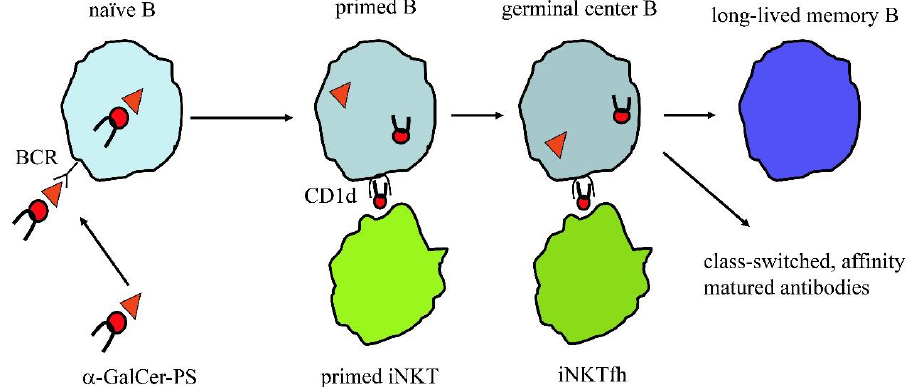
Figure 2. Polysaccharide coupled α -GalCer induces long-lived memory B cells and high-affinity, class-switched antibodies with the help of iNKT cells. A naïve B cell endocytoses the polysaccharide vaccine ( α -GalCer-PS) via its B cell receptor (BCR). The vaccine is processed during its trafficking through the endolysosome and α-galactosylceramide (α-GalCer), an antigen stimulating all iNKT cells, is released from the complex. The free antigen is loaded onto CD1d molecules that also recycles within same endocytic compartment. The CD1d-α-GalCer complexes traffic to the plasma membrane and stimulate iNKT cells. Activated iNKT cells develop into follicular helper iNKT (iNKTfh) cells that participate in a germinal center reaction together with PS-specific B cells and contribute to generation of hypermutated, class-switched antibodies and establishment of immunological memory.